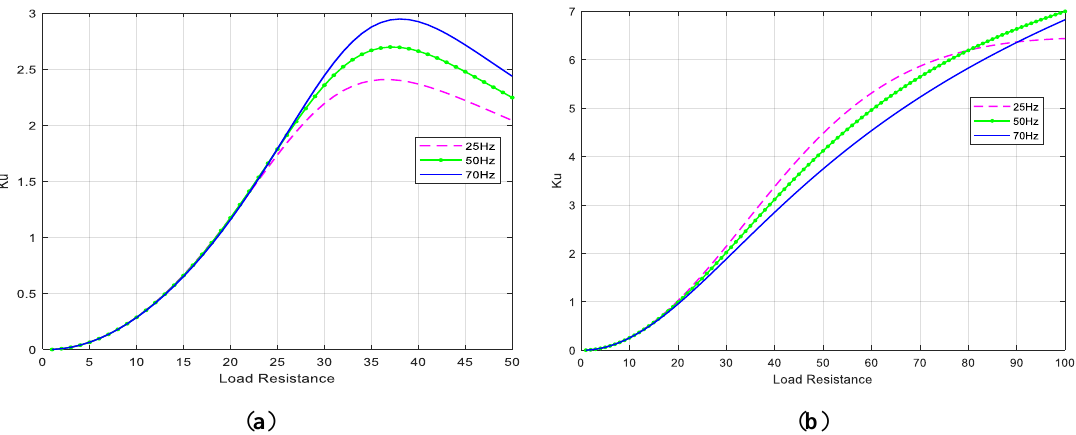
Figure 11. Static characteristics of voltage gain as a function of load: ( a ) Venturini modulation for q = 0.5, ( b ) SVM for q = 0.866 and φ i = 0 .